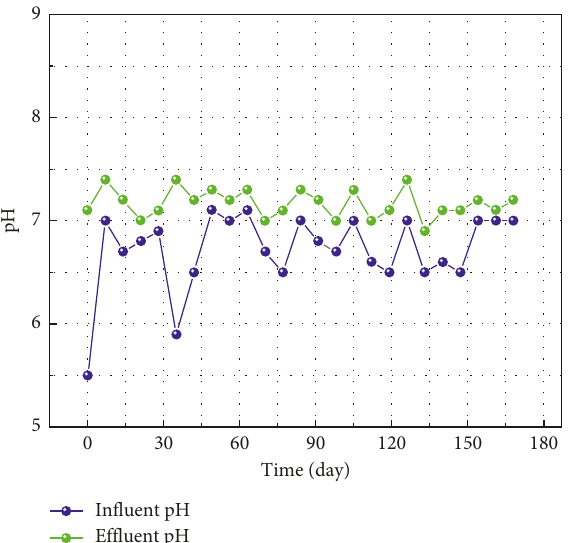
Figure 3: pH during the experimental period.